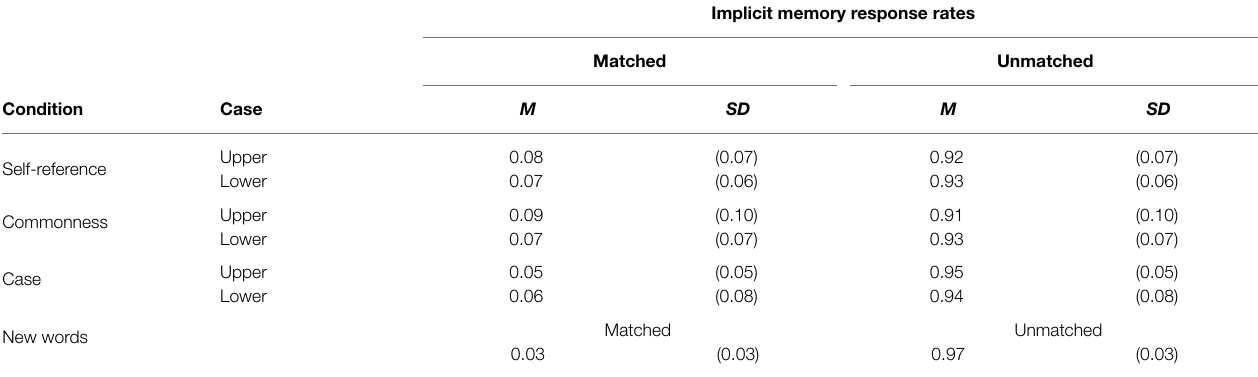
TABLE 4 | Implicit memory.